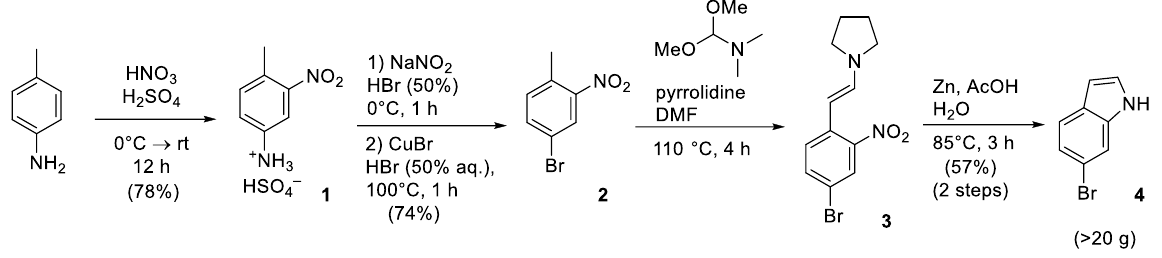
Figure 2. Synthesis of 6-bromoindole.